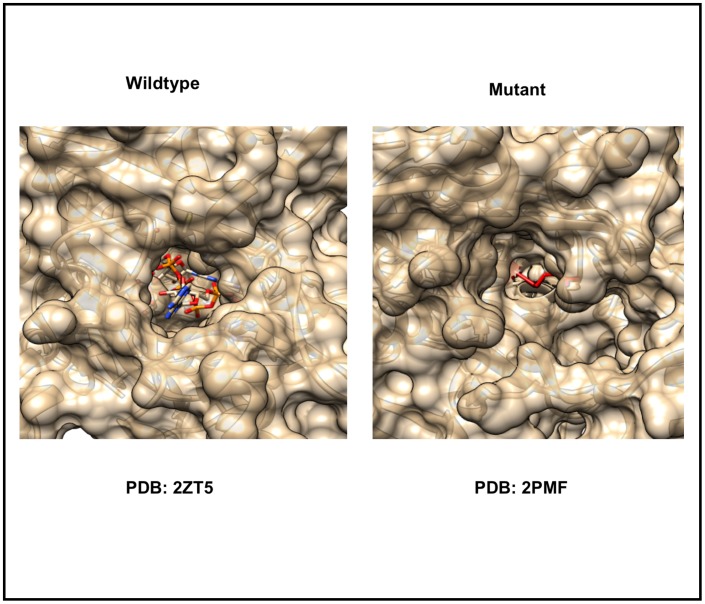
SNV related change that affects enzymatic activity.Semi-transparent, solvent-accessible surface representation of the AMP binding site. For the wild-type structure (PDB: 2ZT5) AMP is bound in the active site (atom type color coded stick figure), while in the mutant structure (PDB: 2PMF) AMP binding is blocked by projection of the arginine sidechain (red) into the active site, thereby blocking substrate ATP binding and inactivating the enzyme.